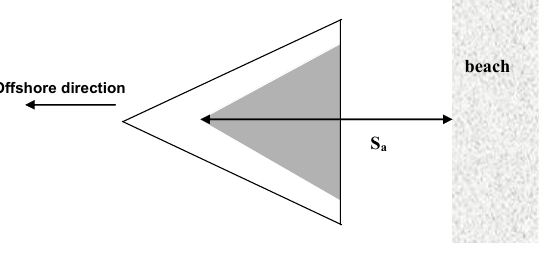
Figure 2. Reef shape and location: definition of S a .